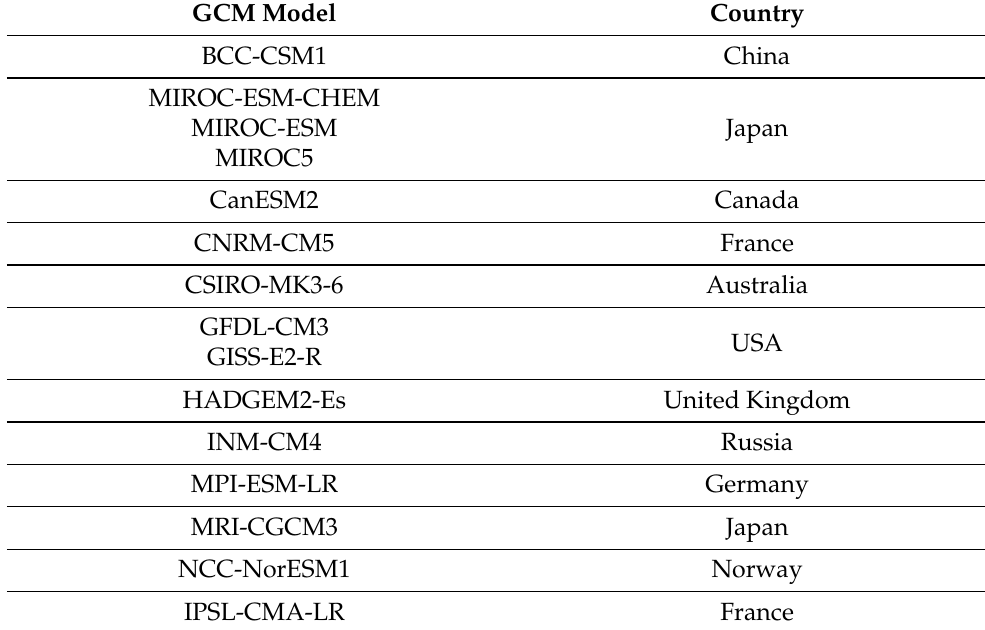
Table 3. List of GCMs considered in the selection of the final model